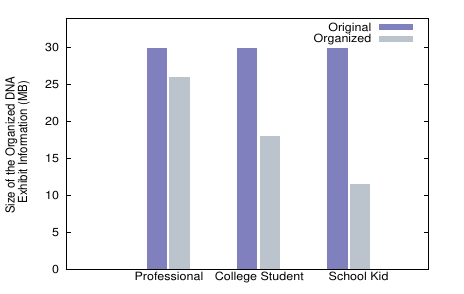
Figure 11. Variation in Size of Organized Exhibit Information of DNA for the Museum